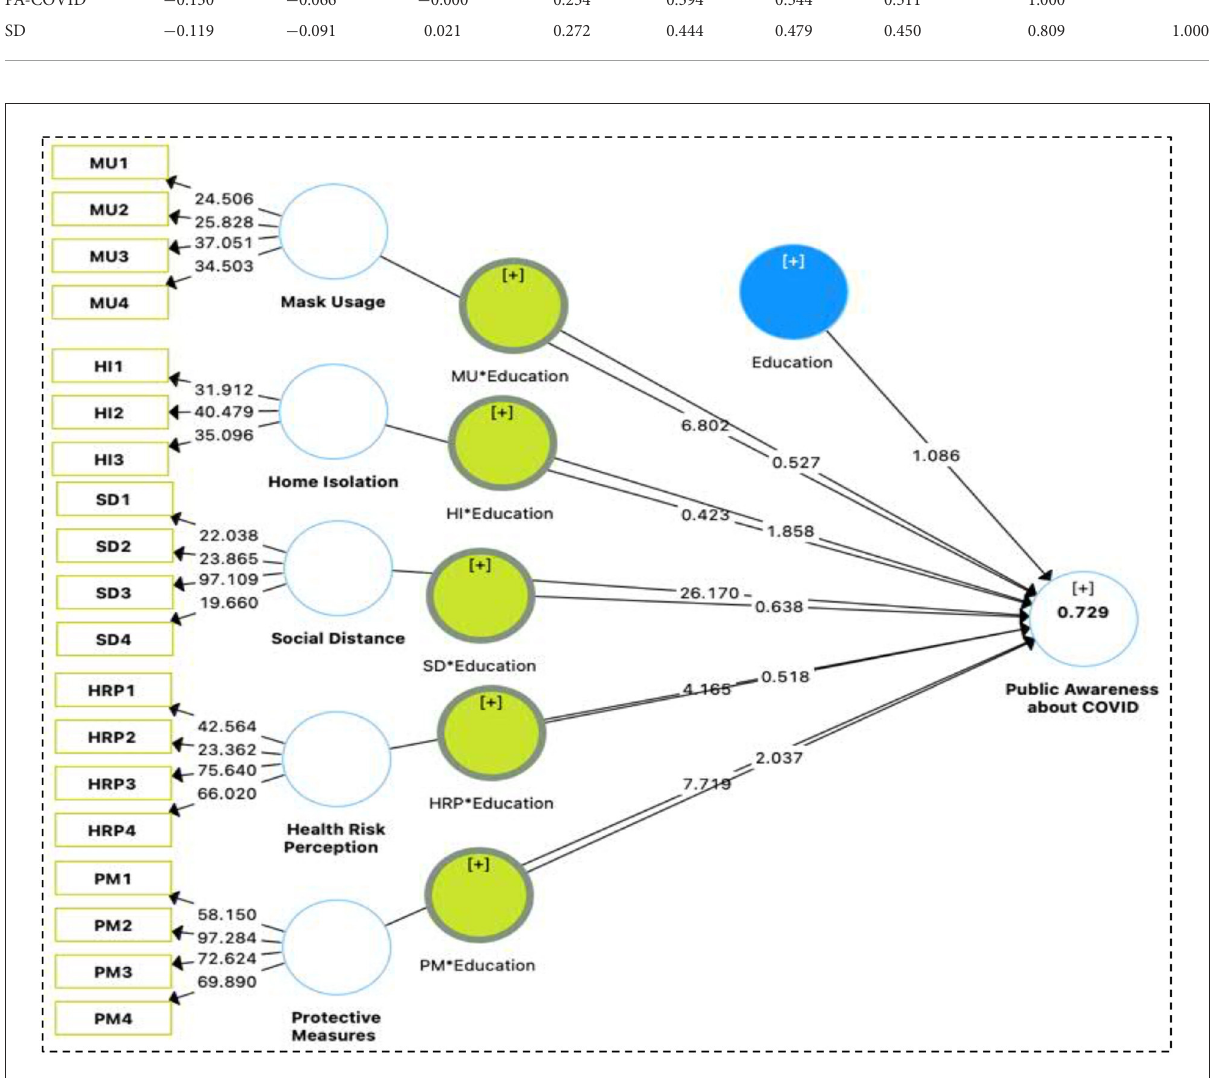
FIGURE5 Moderator